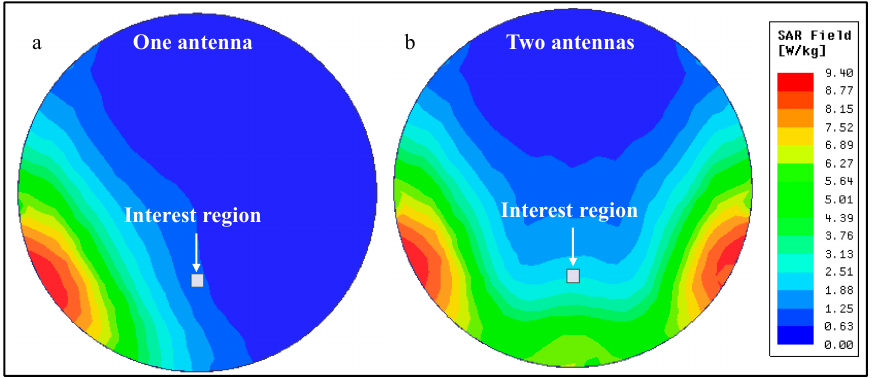
Figure 8. Distribution of 10-g averaged SAR over the human body phantom for: ( a ) one transmission dipole active with 10.2 W of power; and ( b ) both dipoles transmitting 11.2 W each.